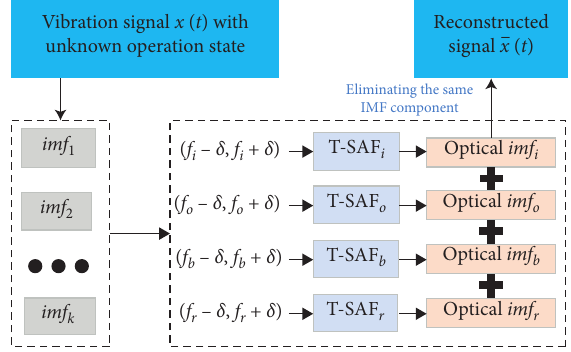
Figure 2: Signal reconstruction flow